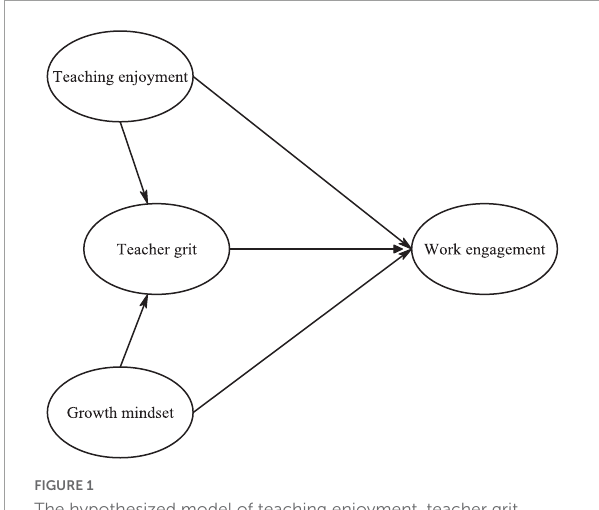
FIGURE1 The hypothesized model of teaching enjoyment, teacher grit, growth mindset, and